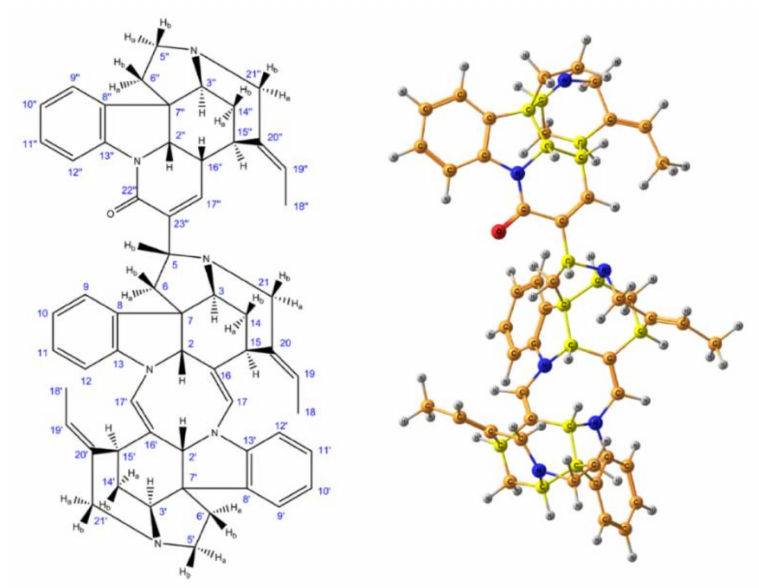
Figure 2. Enumeration of atoms ( left ) and stereochemical structure ( right ) of strychnohexamine. Element colors are as follows: protons—gray, carbons—dark yellow, nitrogens—blue, oxygen—red, while the chiral carbons are given in bright yellow. Reproduced from Semenov et al. [59] with the permission of John Wiley and Sons.